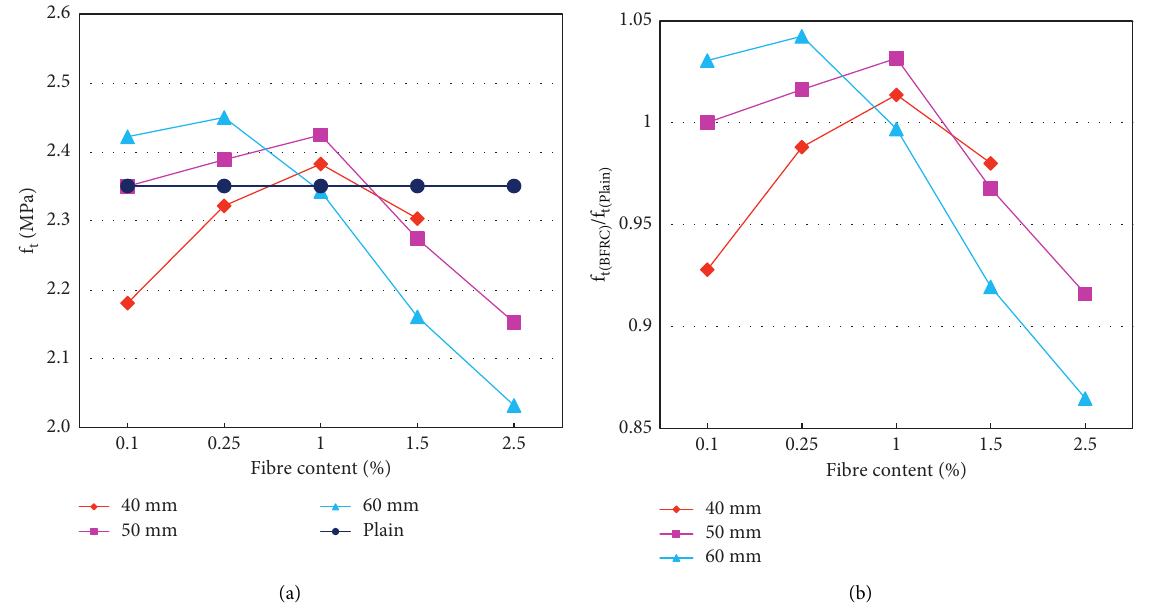
Figure 10: Effect of fibre length and fibre content on split tensile strength of concrete. (a) Splitting tensile strength. (b) Splitting tensile strength reinforced